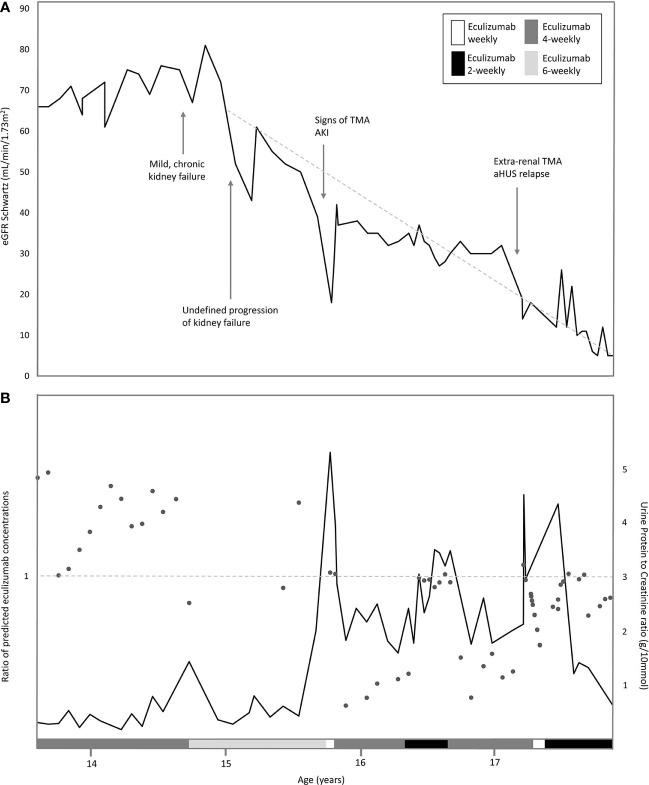
Overview of eGFR, proteinuria and ratio of predicted eculizumab concentrations related to the eculizumab treatment in time. (A) Estimated eGFR (Schwartz formula) indicated with dark grey line, and the various interval treatment periods of eculizumab, indicated by the legends: white bar: eculizumab 1200 mg weekly middle grey colored bar: four-weekly 1200 mg eculizumab; light-grey colored bar 6-weekly 1200 mg eculizumab; dark grey colored bar: two-weekly 1200 mg eculizumab. Dotted line indicates the annual eGFR decline of 22.9 ml/min/1.73m2 (baseline eGFR 68 ml/min/1.73m2). (B) Urine Protein-to-Creatine ratio (g/10 mmol) in time indicated with dark grey line. Ratios of predicted eculizumab concentrations of our patient and a standardized patient of same weight indicated with dots. Ratio =1 (horizontal dotted line), normal clearance; Ratio >1, decreased clearance in our patient (eculizumab concentrations higher than expected); Ratio <1; increased clearance in our patient (eculizumab concentrations lower than expected.